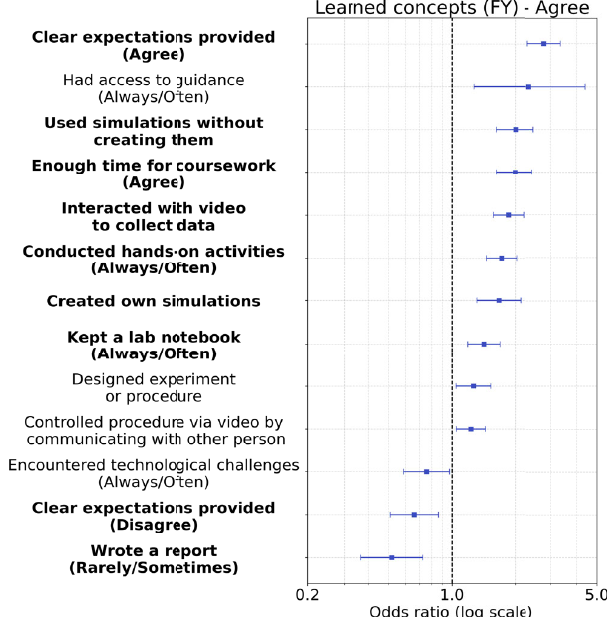
FIG. 7. Logistic regression odds ratios for students who agreed or strongly agreed that they learned concepts in their course compared with all other students. Only variables with uncorrected p values less than 0.05 are shown. Bold variables are those that are statistically significant after the Holm-Bonferroni correction. Error bars show 95% confidence intervals. The odds ratios are on a log scale to make the positive and negative effects be of approximately equal